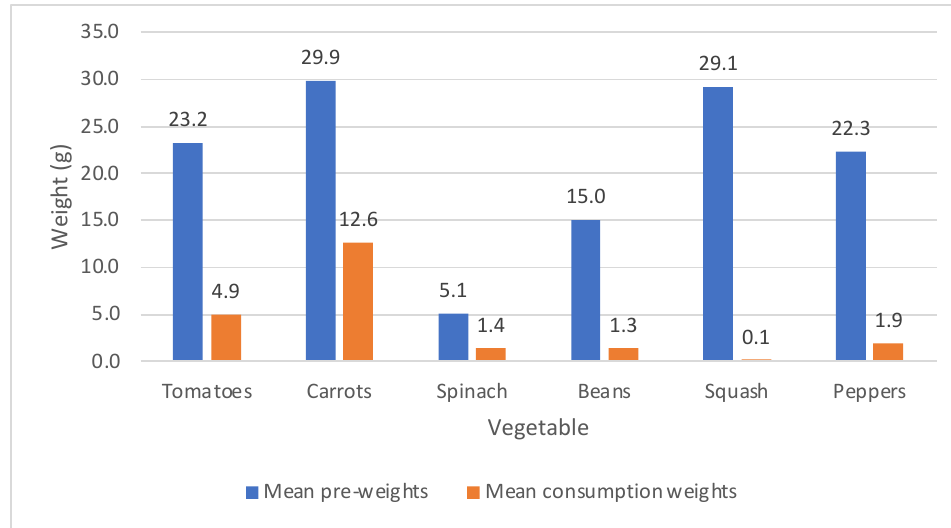
Figure 1. Mean pre-consumption weights and mean consumption weights for each vegetable. The mean total FR-WTT score was 9.3 ( SD = 7.3, range = 0 – 24). We observed only 5% of children placing all six vegetables into their mouths and swallowing and a little over one-quarter of children (30%) did not touch any of the vegetables. Figure 2 displays the distribution of children’s willingness-to-try behaviors according to the FR-WTT for each vegetable. More children were willing to try carrots (70%) and spinach (42%) by at least putting these vegetables in their mouths (FR-WTT scores of 3 or 4). Children were least willing to try squash and beans with 64% and 62% not removing these vegetables from the vegetable snack box, respectively.